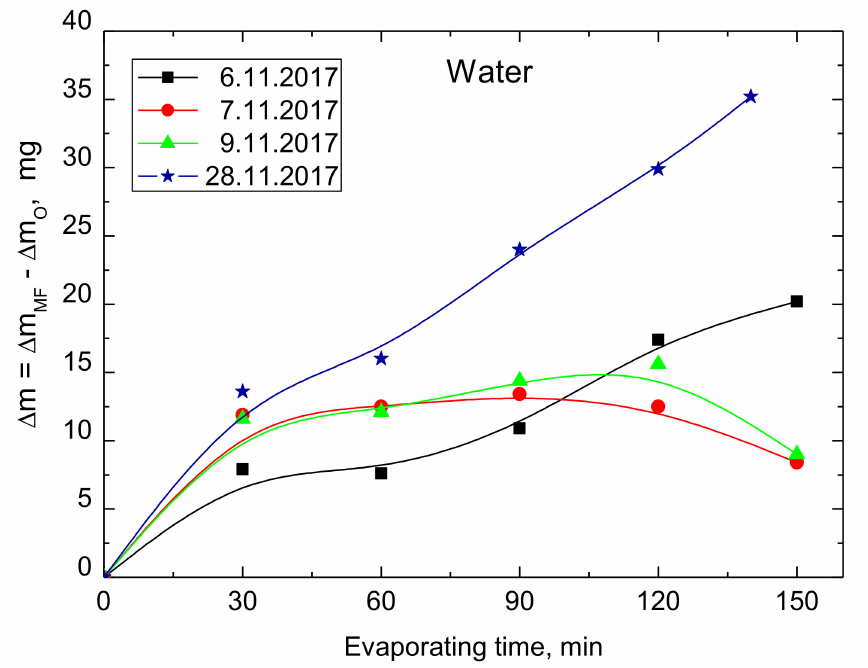
Figure 4. Differences in the evaporated amounts of water from the MF-treated and untreated samples obtained in four independent